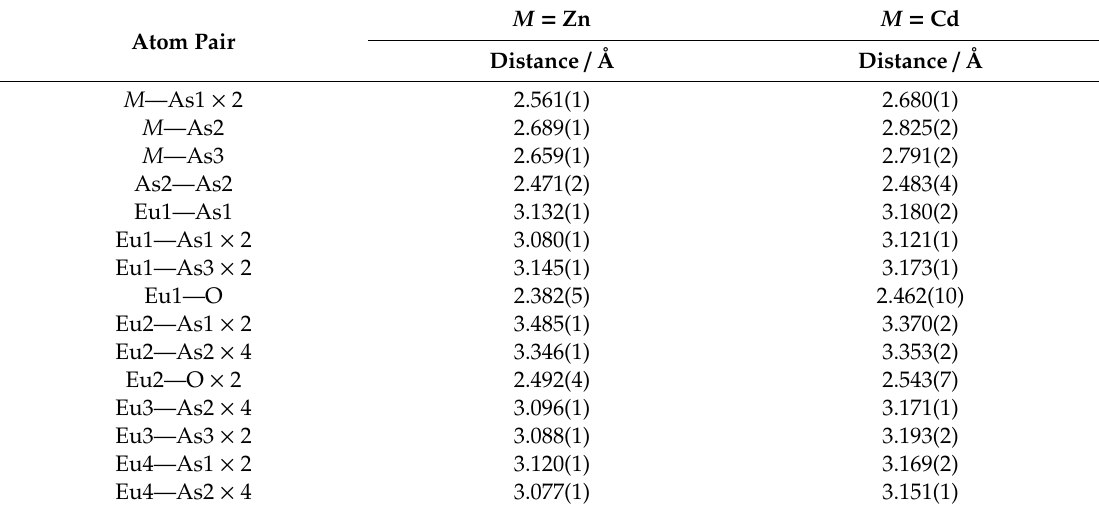
Table 3. Selected bond distances in Eu 5 M 2 As 5 O ( M = Zn, Cd).